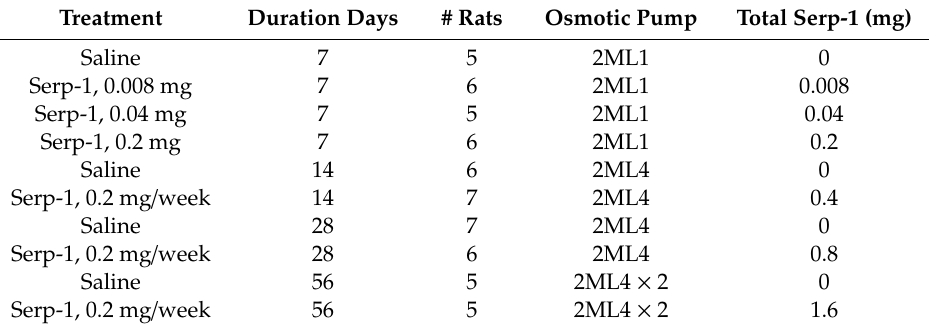
Table 1. Rats with spinal cord injury infused subdurally with